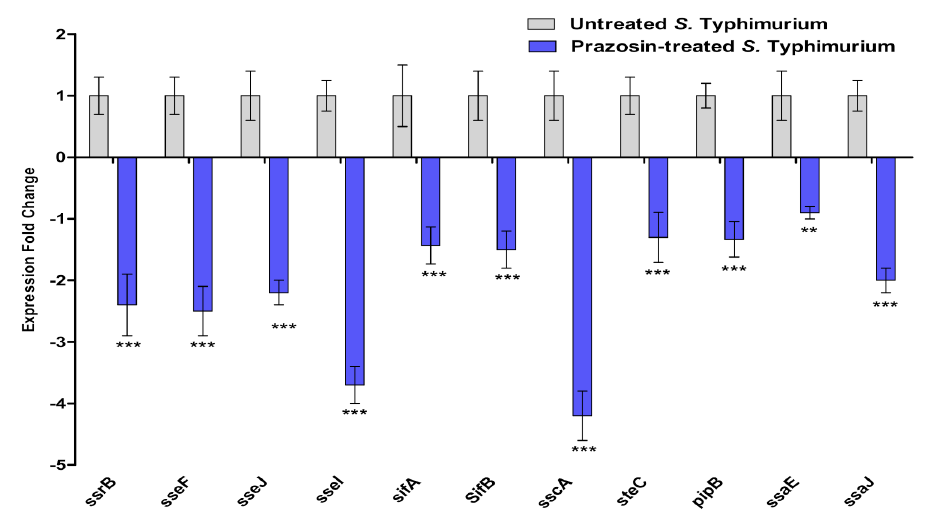
Figure 7. Prazosin decreased the T3SS-type 2 encoding gene expression. Prazosin at sub − MIC significantly decreased the expression of T3SS-type 2 encoding genes (*** = p < 0.0001; ** = p < 0.001).